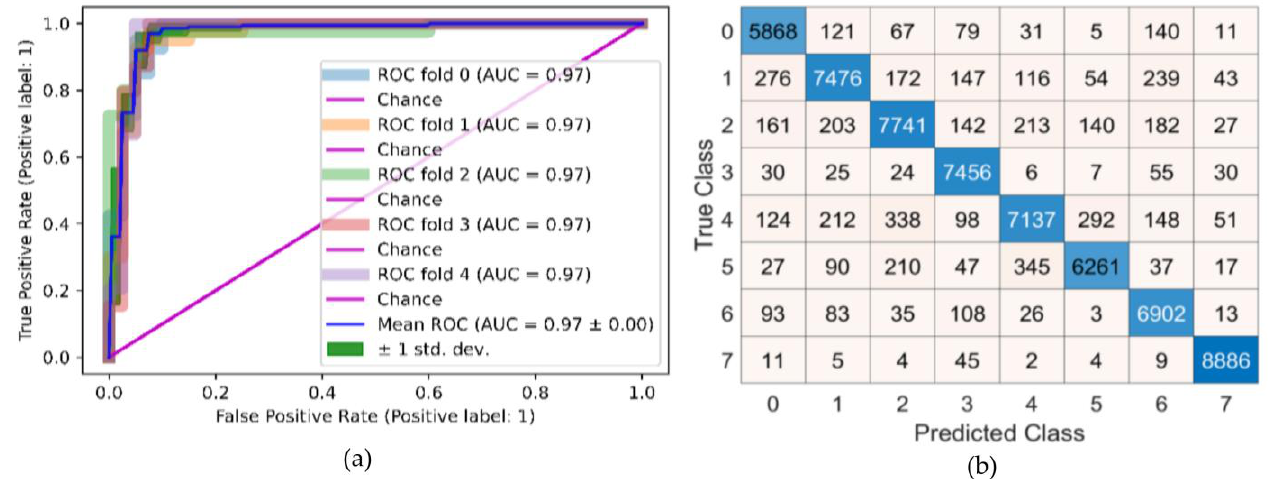
Figure 11. Classification results on ISIC 2019 ( a ) ROC Curve of fine KNN ( b ) confusion matrix of fine KNN. Table 8. Proposed classification model outcomes on the MED-NODE